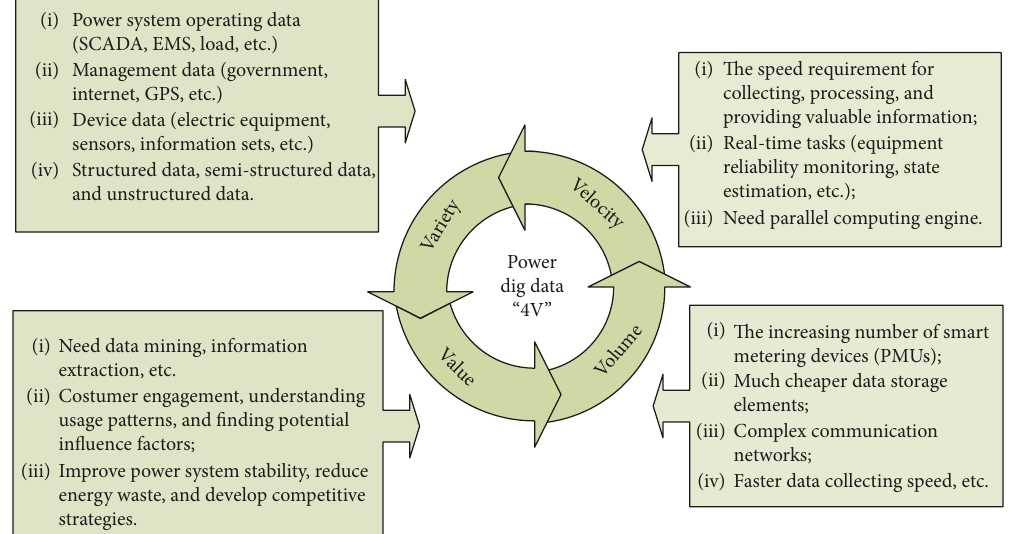
Figure 1: Power system Big Data 4V